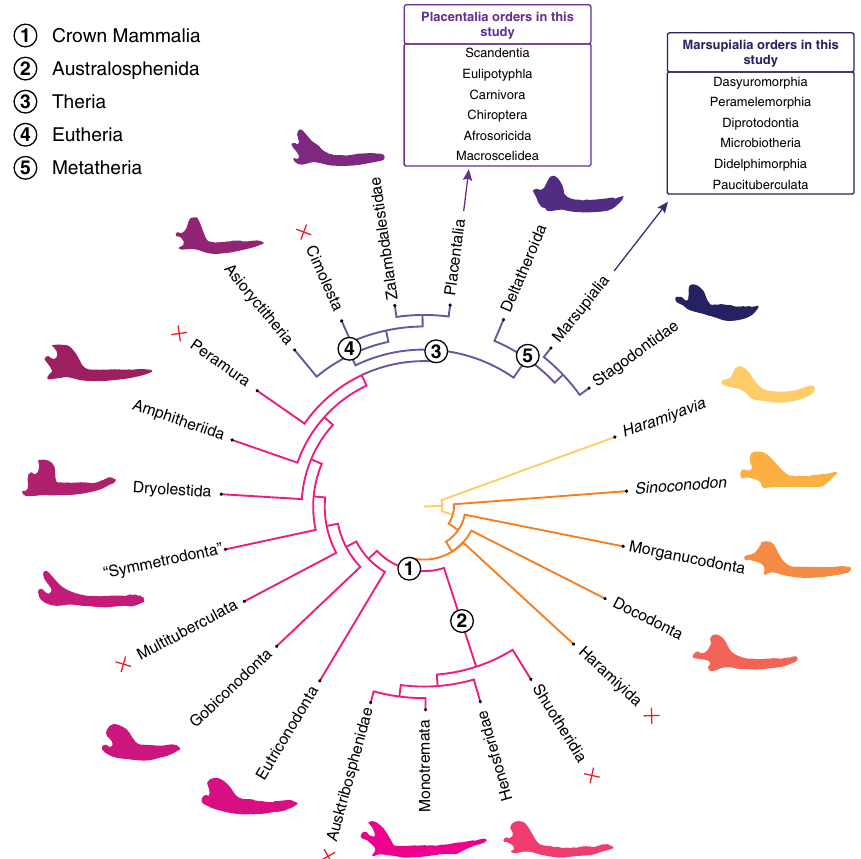
Fig. 1 Summary of the phylogeny used in this study. Overall topology from refs. 60,61 . Other references in Methods section. Red crosses indicate clades not included in the